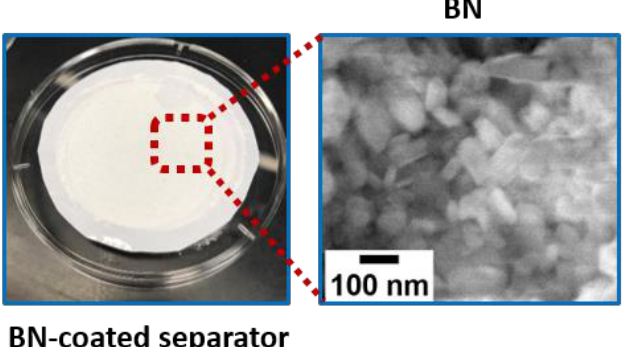
Figure 2. Picture represents the coating of BN on the separator.